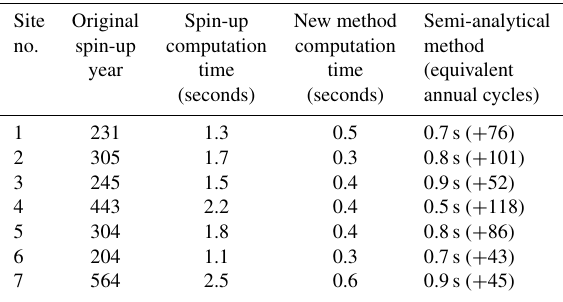
Table 2. Spin-up time comparison for different methods for seven study sites; seconds represent real computation time, and years refer to the annual spin-up